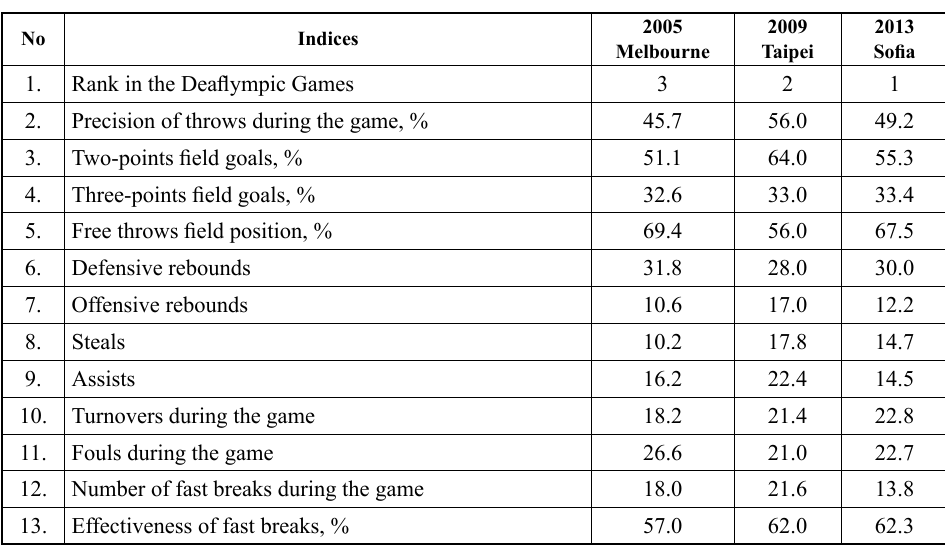
Table 4. Character- istics of Lithuanian deaf basketball na - tional team members in three Deaflympic